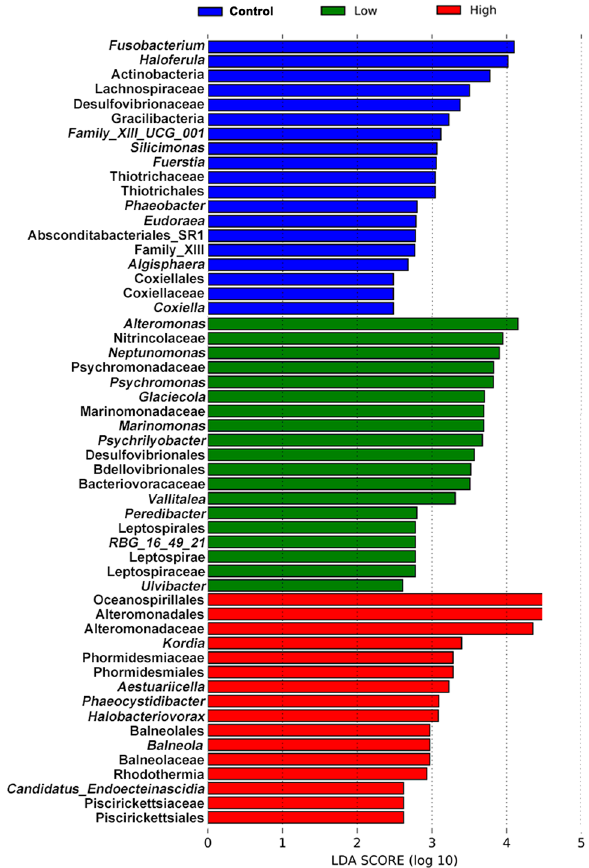
Figure 3. Bacterial species with significant differences in abundance on S. thunbergii under increased UV-B radiation (Forest plot showing taxa whose abundance was significantly different between the control group (blue), low-UV-B radiation group (green) and high UV-B-radiation group (red), as determined using the KW test. LDA score (effect size) indicating significant differences in bacterial taxon abundance ( P value: Wilcoxon rank-sum test, LDA score >